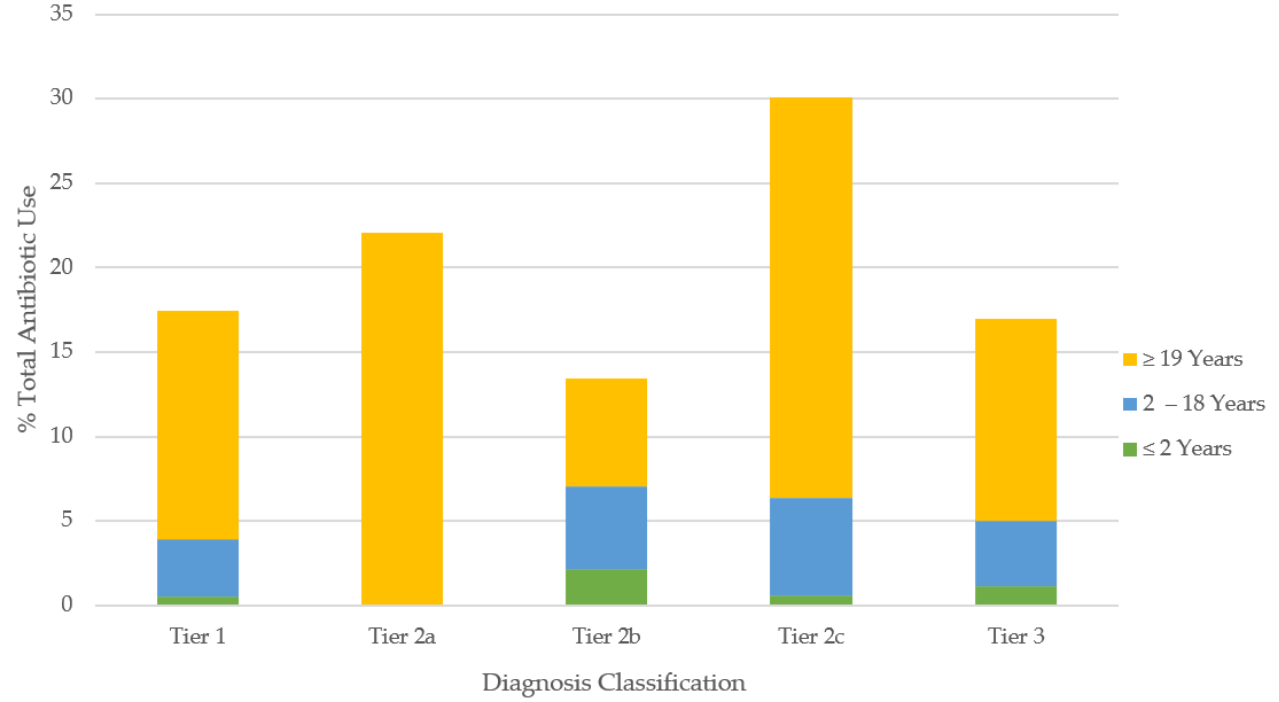
Figure 1. Proportion of all antibiotics prescribed for common infections according to tier classification. Tier 1 = antibiotics always indicated (maximal rate 100%); tier 2a = antibiotics frequently indicated (maximal rate: 51–99%); tier 2b = antibiotics sometimes indicated (maximal rate: 21–50%); tier 2c = antibiotics rarely indicated (maximal rate: 1–20%); tier 3 = antibiotics never indicated (maximal rate: 0%).